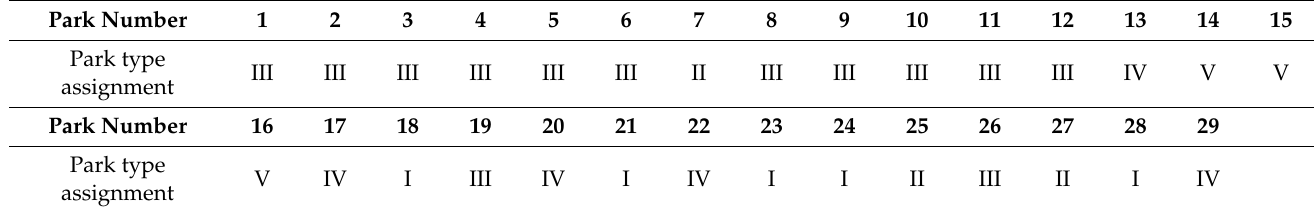
Table 8. The results of park type assignment of country parks.